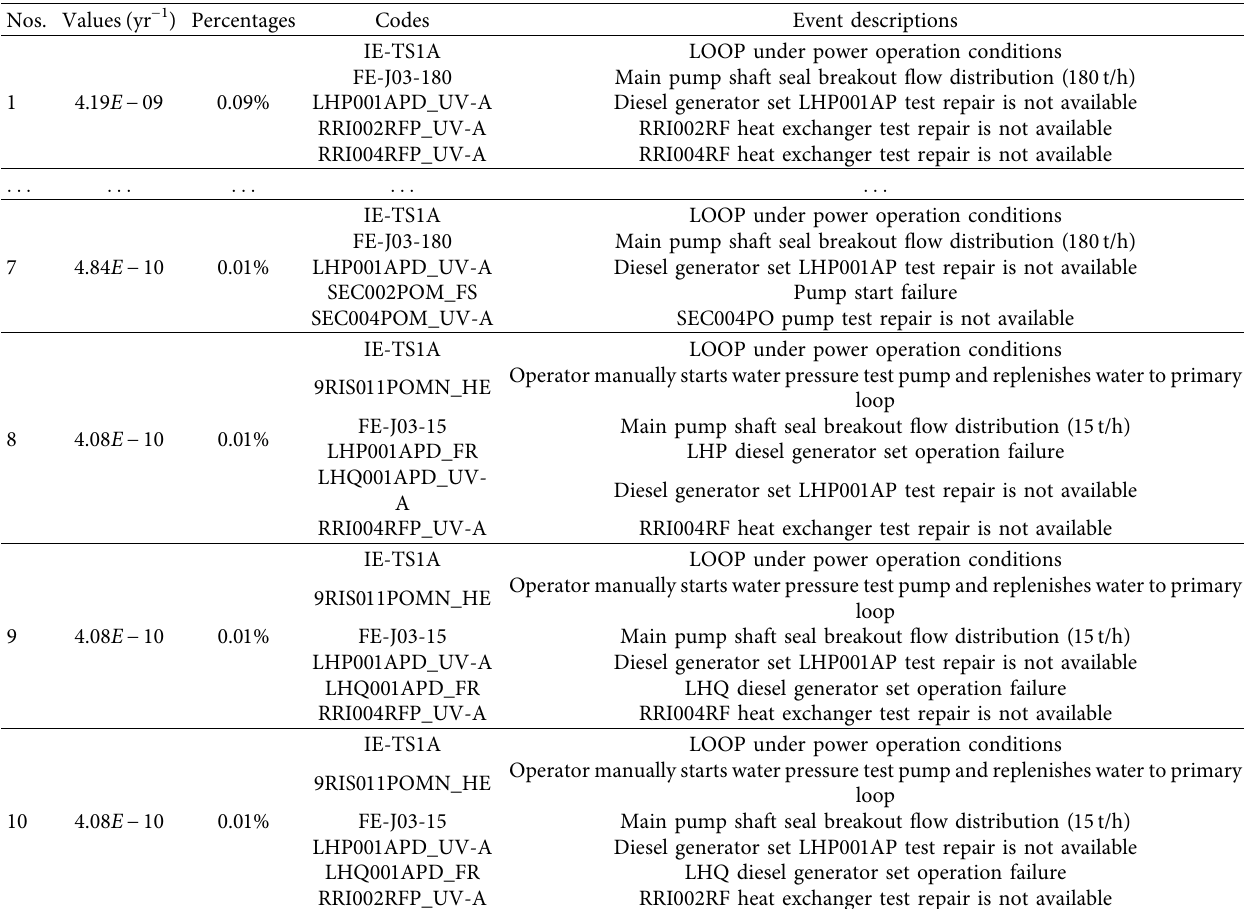
Table 6: Contains MCS for test repair of diferent equipment. Nos. Values (yr − 1 )